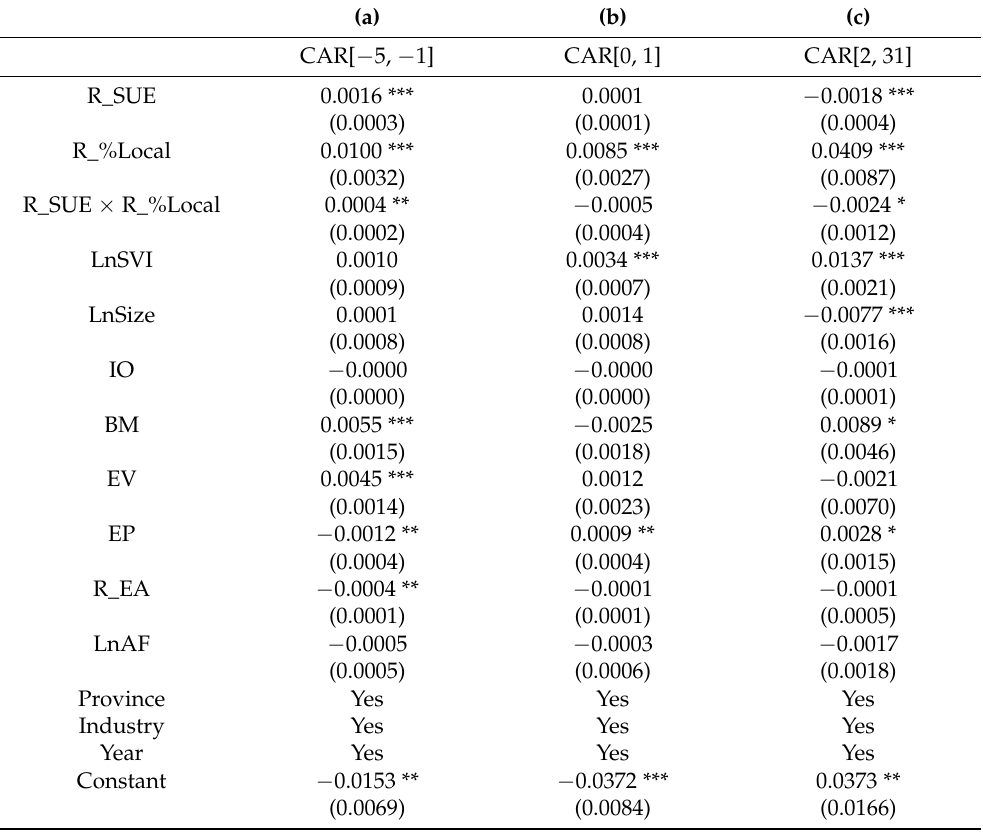
Table 11. Empirical Results of CARs of Fama-French model as Dependent